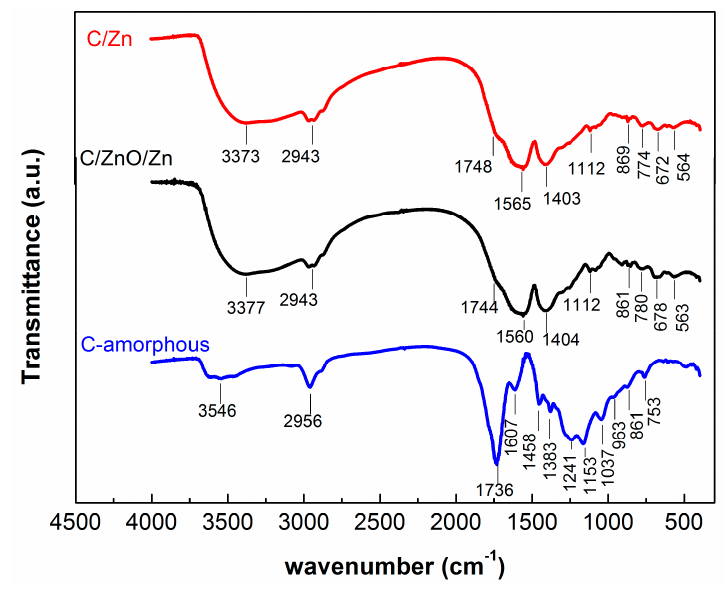
/ Zn, C / ZnO / Zn, and Figure 2. FTIR spectra of C/Zn, C/ZnO/Zn, and C-amorphous. Figure 2. FTIR spectra of C Figure 2. FTIR spectra of C/Zn, C/ZnO/Zn, and C-amorphous.